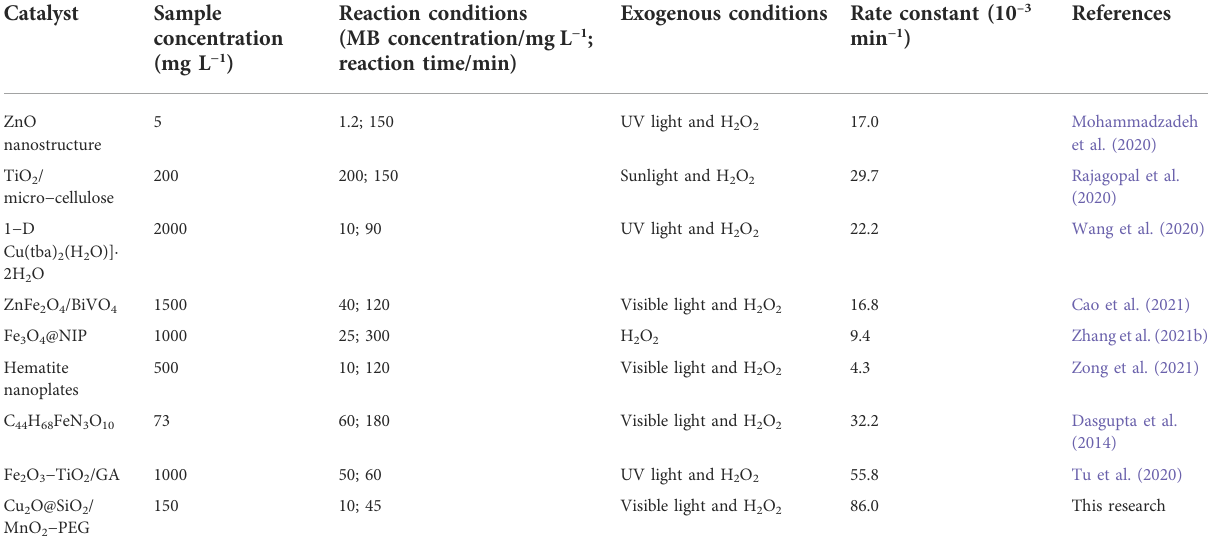
TABLE 1 Catalytic performances of catalytic degradation of MB dye reported elsewhere.